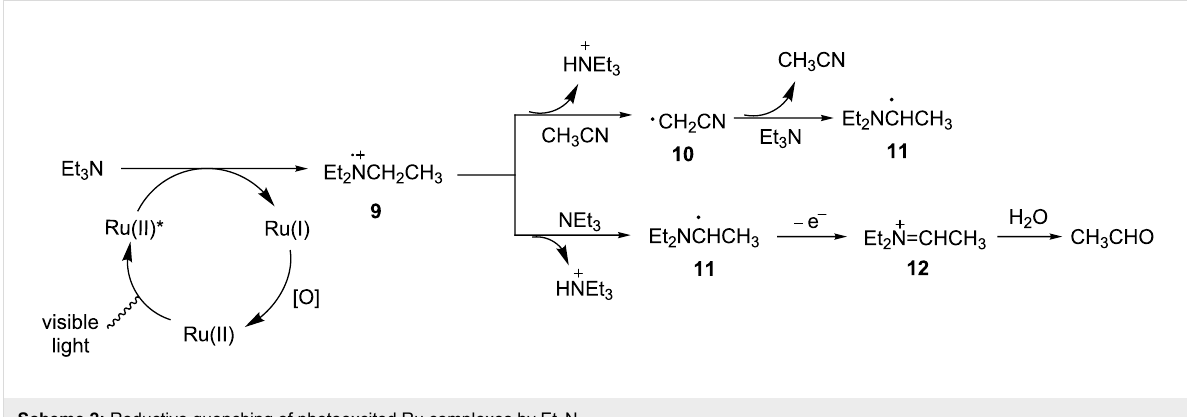
Scheme 2: Reductive quenching of photoexcited Ru complexes by Et 3